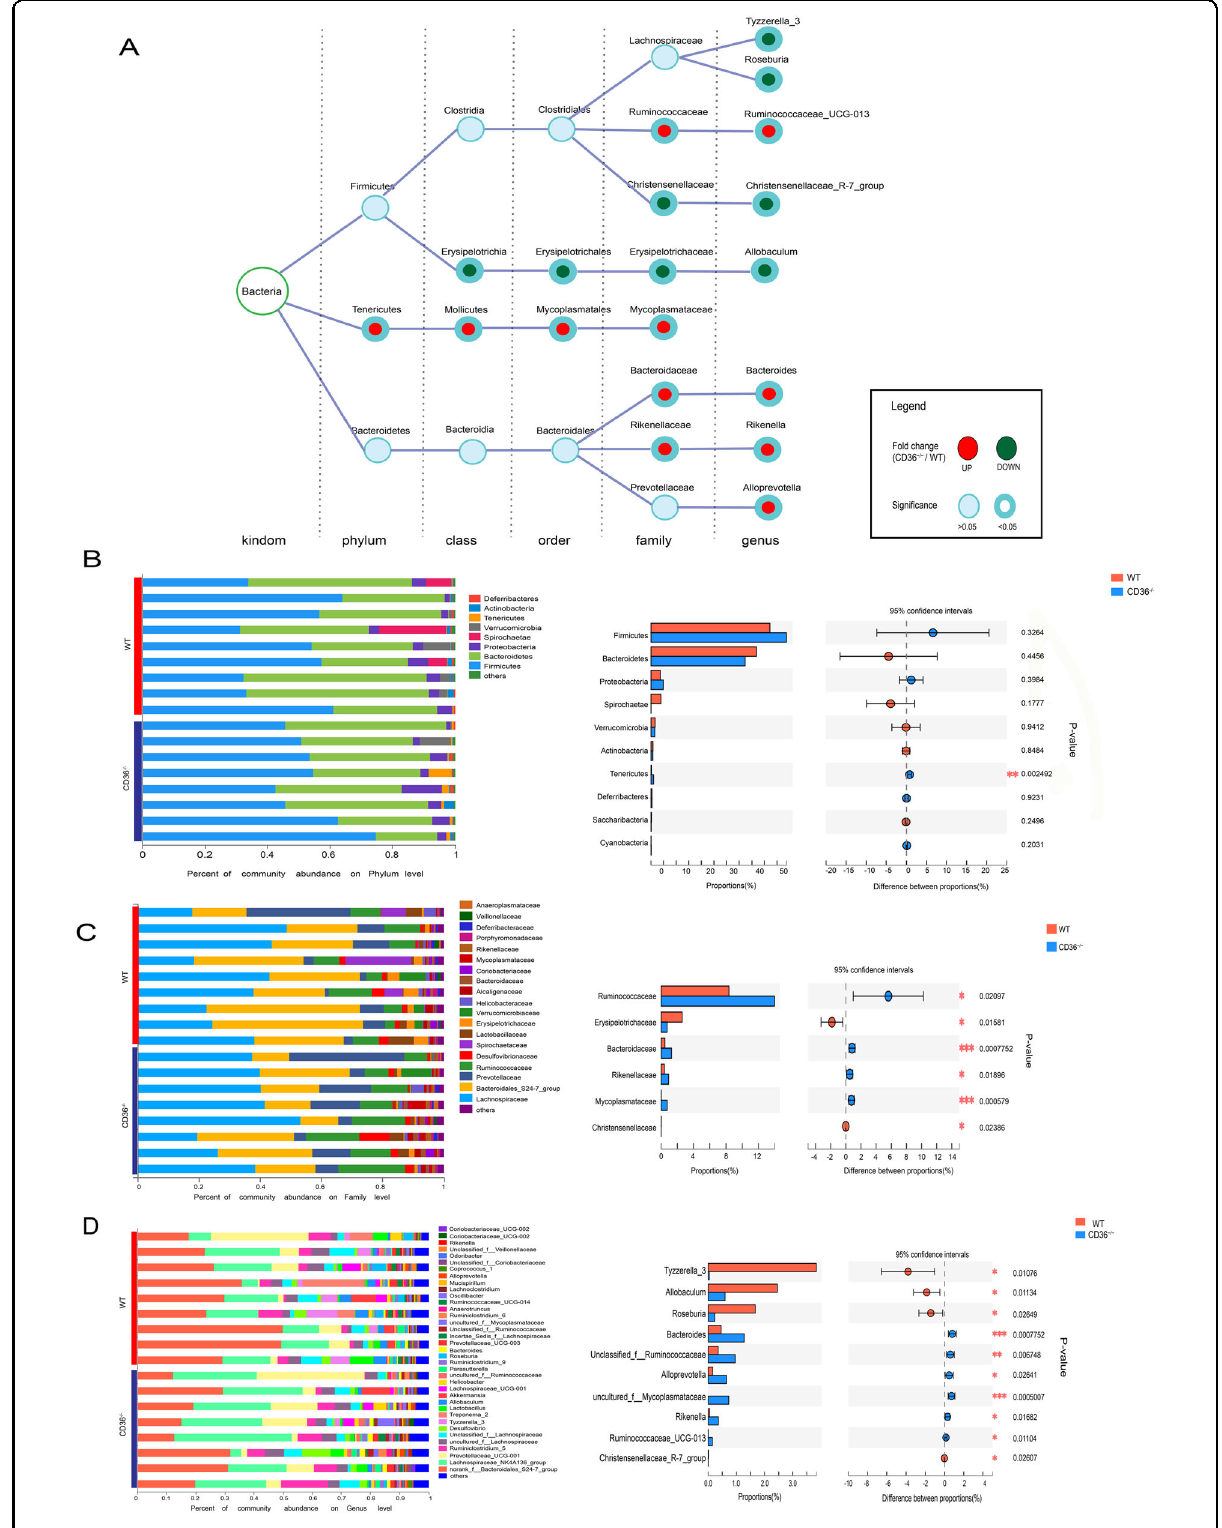
Fig. 3 Taxonomic differences in cecal microbiota between WT and CD36 − / − mice. a The differences in taxonomic abundance between the different groups. b Classi fi cation and abundance of cecal contents at the phylum level. c Classi fi cation and abundance of cecal contents at the family level. d Classi fi cation and abundance of cecal contents at the genus level ( n = 8 – 9 mice/group, * P <